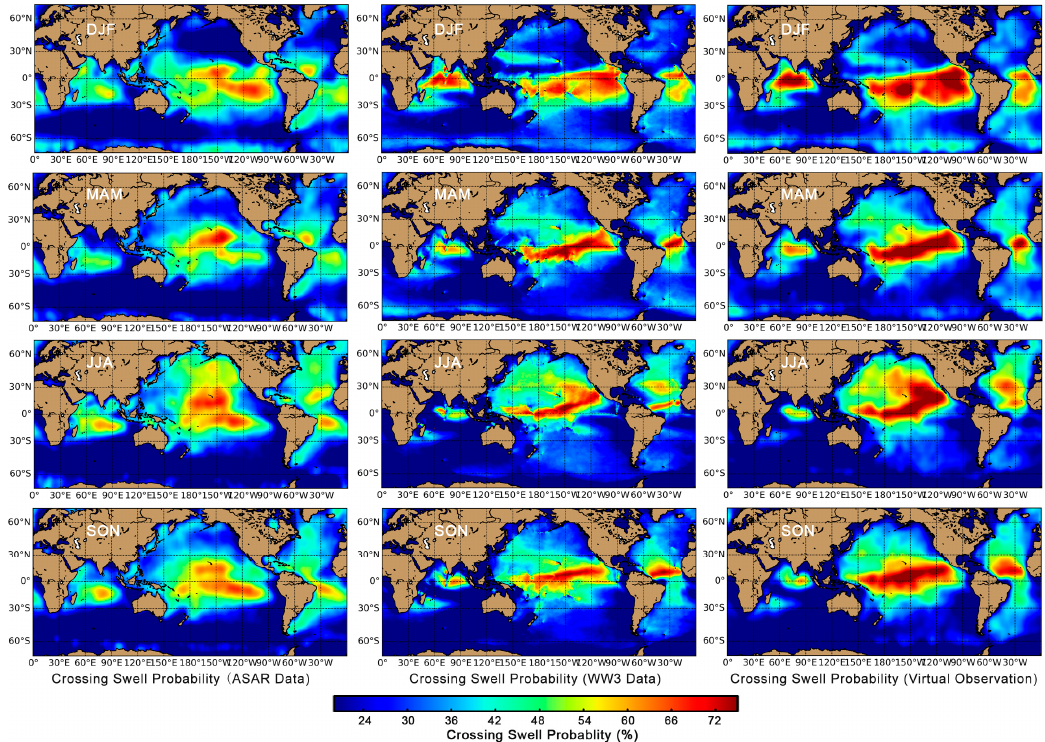
Figure 1. Global distributions of crossing swell probabilities from ( left ) Globwave ASAR dataset, ( middle ) WW3 outputs, and ( right ) WW3 virtual observation dataset for December–February (DJF, 1st row), March–May (MAM, 2nd row), June–August (JJA, 3rd row), and September–November (SON, 4th row).